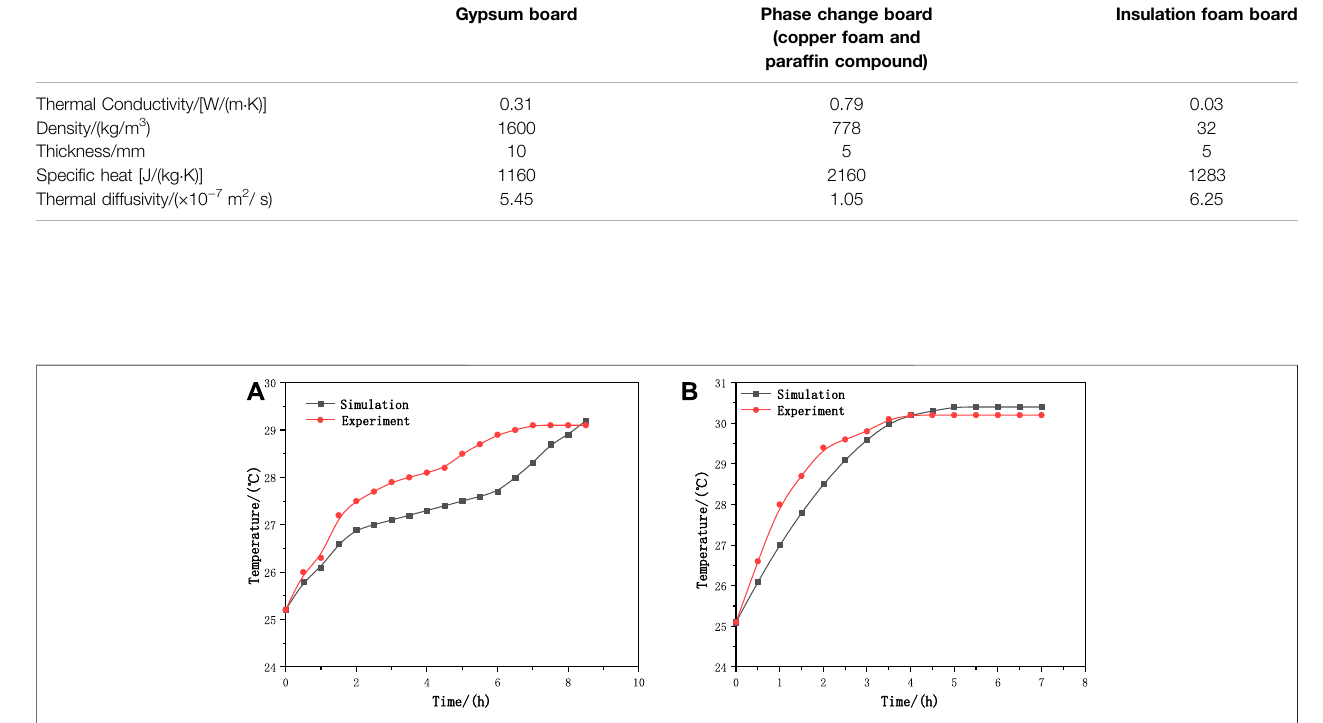
FIGURE 10 | Experimental vs simulation results of indoor air temperature: with phase change (A) and without phase change (B) .